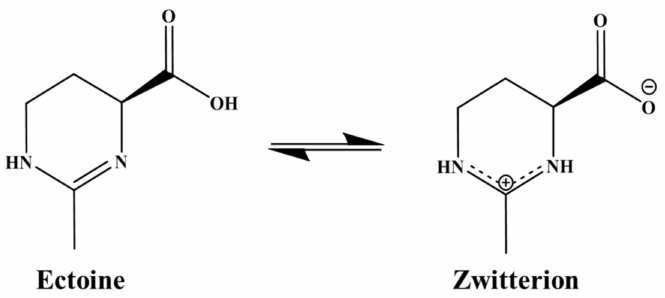
Figure 2. Zwitterion form of ectoine containing both acid and base centers and its isomer. The pH of the solution with resin was adjusted using NaOH solution (3 M) with a long enough time for equilibrium to be reached. Table 2 indicates that the equilibrium adsorption capacity of ectoine (q e ) is affected by pH values. q e remained stable before the pH rose to over 3, slightly decreased at pH 4, and dramatically dropped at pH values over 4. After adsorption, the pH was reduced when it was lower than 4; in contrast, it increased when it was higher than 4. Therefore, the maximum adsorption was a 9.8 mg/g (0.07 meq/g) adsorption capacity of ectoine under pH < 3 when using an initial ectoine concentration of 1000